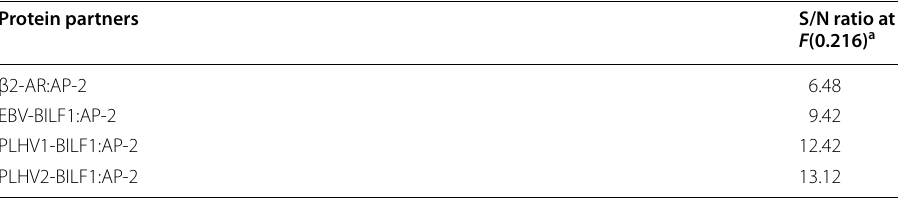
Table 1 Interaction (S/N ratio) of BILF1 receptors with AP-2 determined using the informational spectrum method